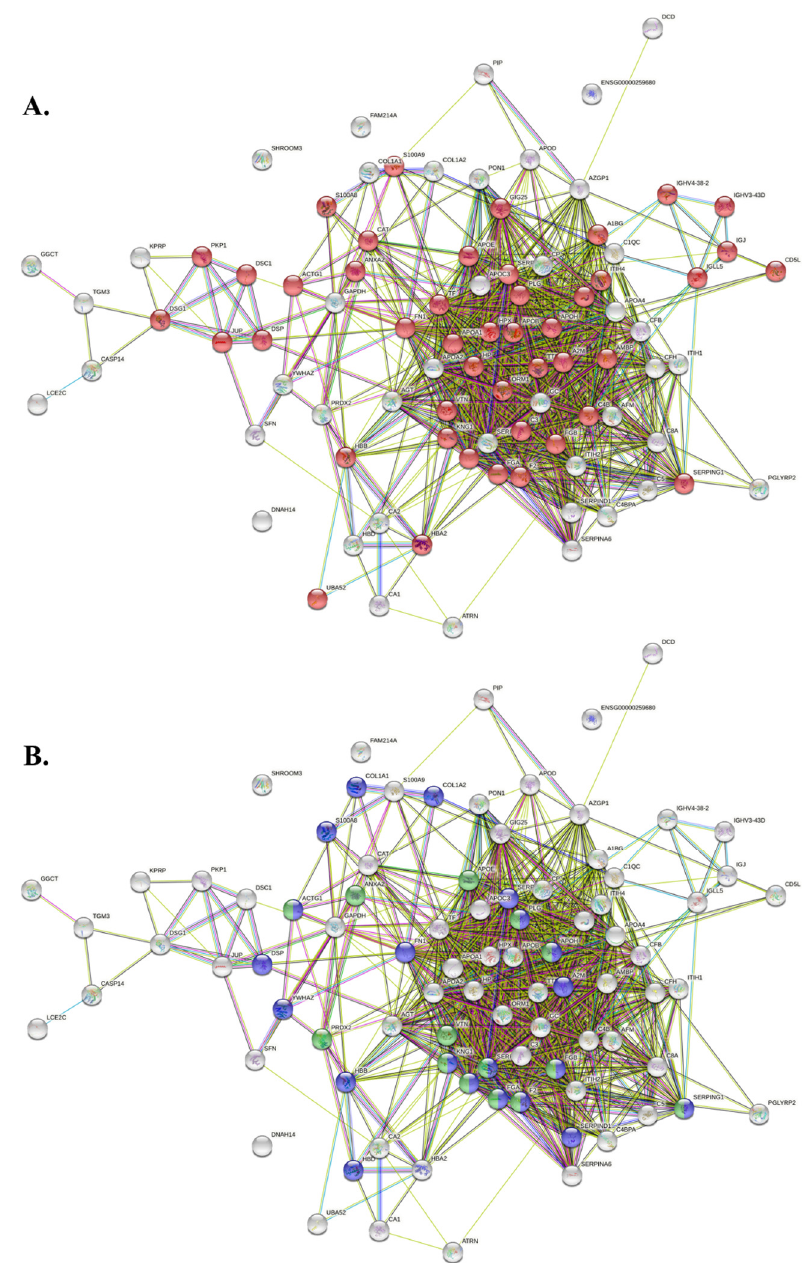
Figure 5. Network representing the interactions existing among the 105 PRP-EV proteins reported in Table 1. ( A ) Red dots represent the proteins involved in the “vesicle-mediated transport”. ( B ) Blue dots represent the proteins associated with “wound healing”, whereas green dots are related to the proteins regulating the wound healing process.